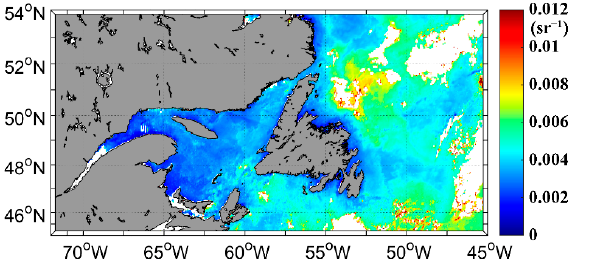
Figure 10 . The monthly average Rrs product of HY-1C-COCTS in October 2020 calculated using the neural network algorithm .